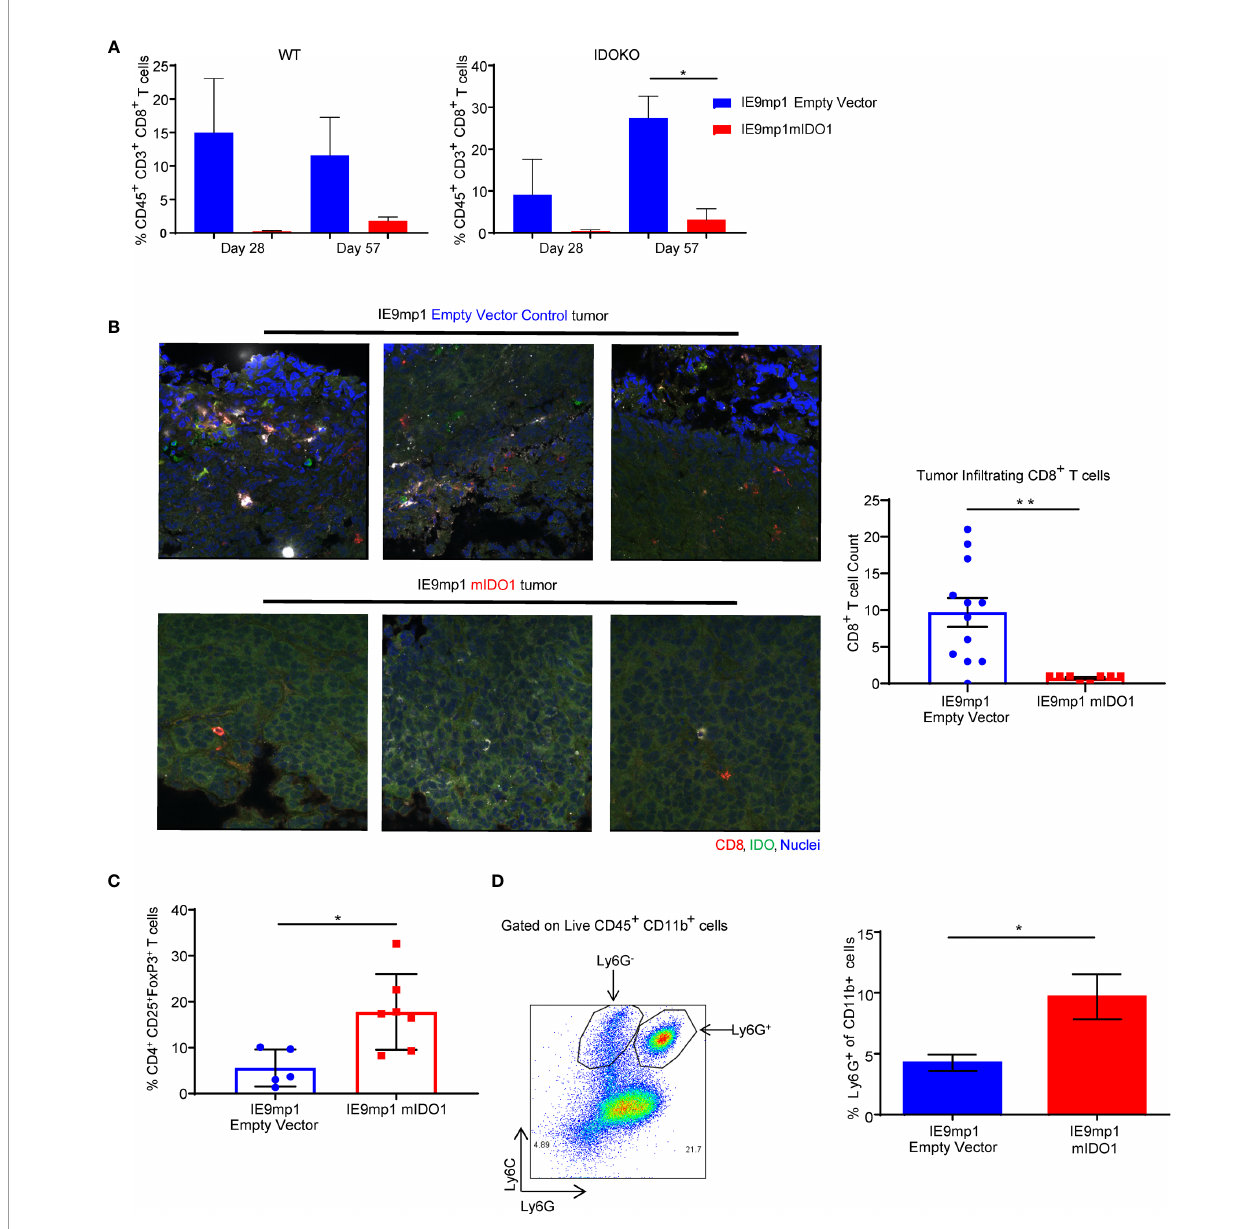
FIGURE 3 | Expression of IDO1 leads to poor tumor in fi ltration by CD8+ T cells and increased in fi ltration of suppressive immune cells in the ovarian tumor microenvironment. (A) Frequency of CD8+ TILs on Days 28 and 57 from WT C57BL/6 (left panel n=6) and IDOKO (right panel n=6) mice challenged i.p. with 1x10e7 IE9mp1-mIDO1 or IE9mp1-EV tumor cells. (B) Immuno-stained IE9mp1-mIDO1 and IE9mp1-EV tumor from WT C57BL/6 mice on Day 48 with anti-IDO1 (green), CD8+ T cell (red), and DAPI (blue). Quanti fi cation of CD8+ T cells from 3 fi eld images per tissue slide, (n=11 IE9mp1-EV and n=8 IE9mp1-mIDO1). Total original magni fi cation is 63x. (C) Flow cytometry analysis of tumor ascites for CD4 + CD25 + FoxP3 + T cell frequency in IE9mp1-mIDO1 (n=7) and IE9mp1-EV (n=5) tumor- bearing WT C57BL/6 mice on Day 48. (D) Frequency of Ly6G+in CD11b + cell IE9mp1-EV (n=5) or IE9mp1-mIDO1 (n=5) tumor-bearing WT C57BL/6 mice on Day 28. *p < 0.05, **p < 0.01, using Student ’ s t test (B – D) . The data represent means ± SEM of three independent